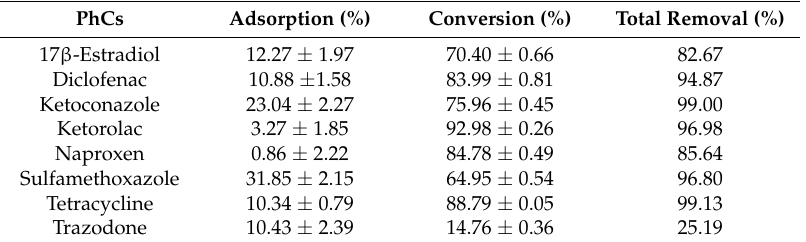
Table 2. Oxidation and adsorption of the PhCs by the CPO–chitosan macrospheres.